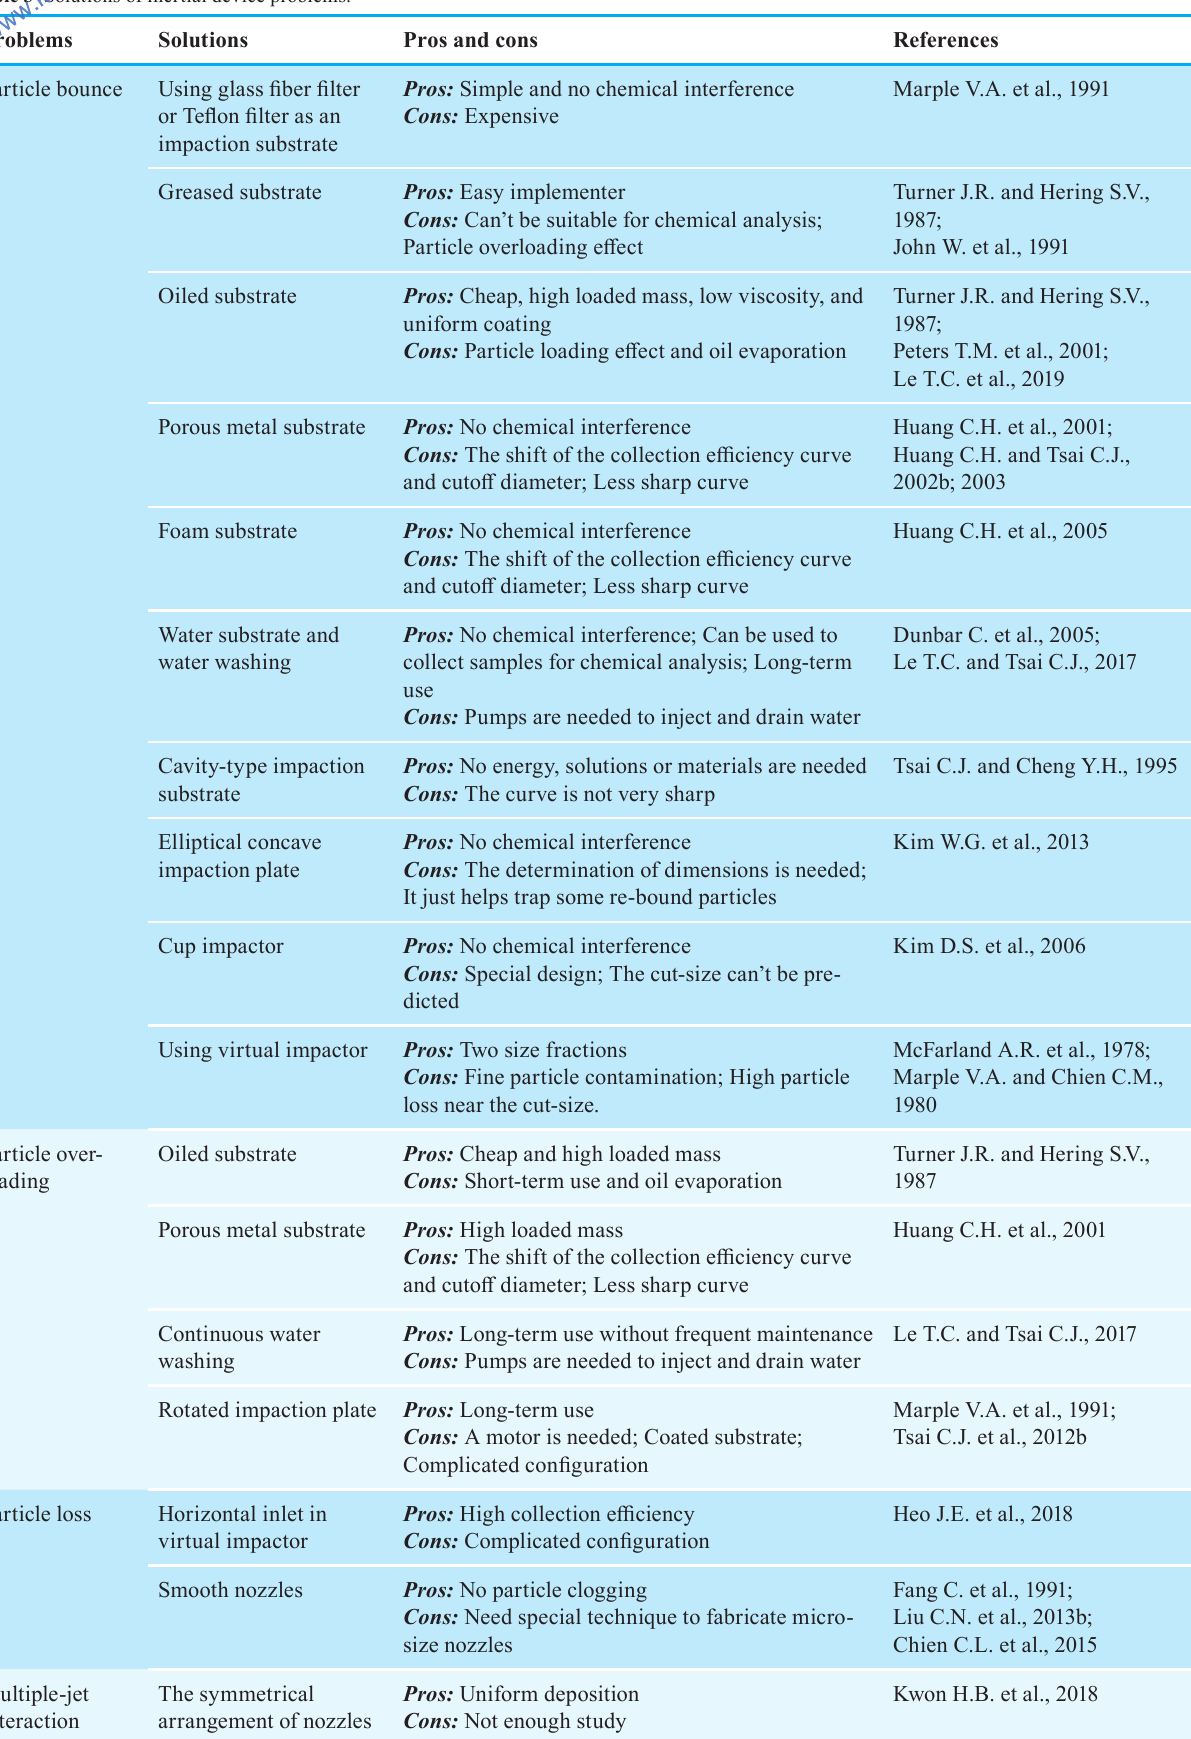
Table 3 Solutions of inertial device